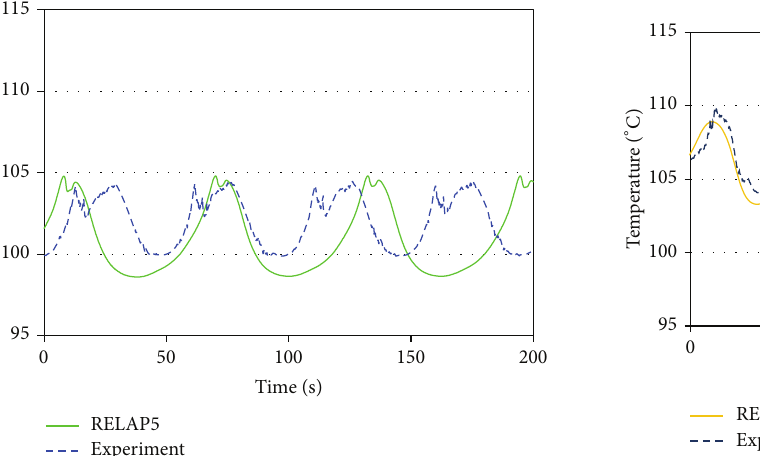
Figure 15: Inlet riser water temperatures, test